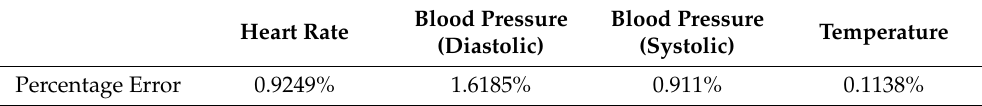
Table 15. The percentage error between the reference device and the proposed